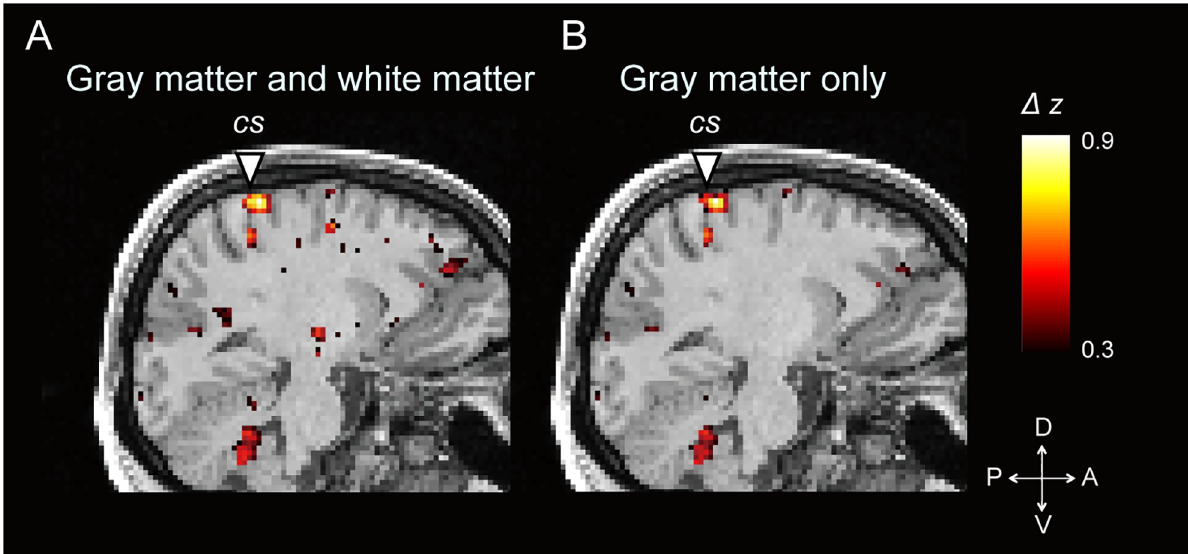
Fig 5. Two ways of calculating interhemispheric connectivity maps. (A) A differential interhemispheric connectivity map calculated simply between symmetrical voxels in the two hemispheres. Therefore, the voxel in the contralateral hemisphere can be gray matter or white matter. The map is the same as Fig 4A. (B) A differential interhemispheric connectivity map calculated in another way. The map was calculated between a gray matter voxel in one hemisphere and the gray matter voxel located nearest to the corresponding voxel in the contralateral hemisphere, if the corresponding voxel is judged as white